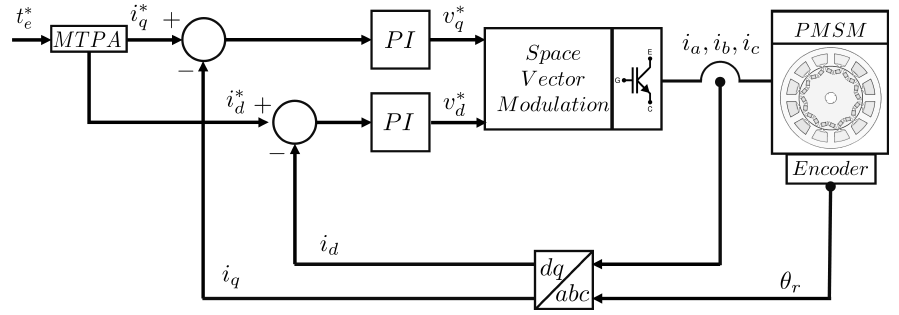
Figure 1. Stator current regulation loop in FOC